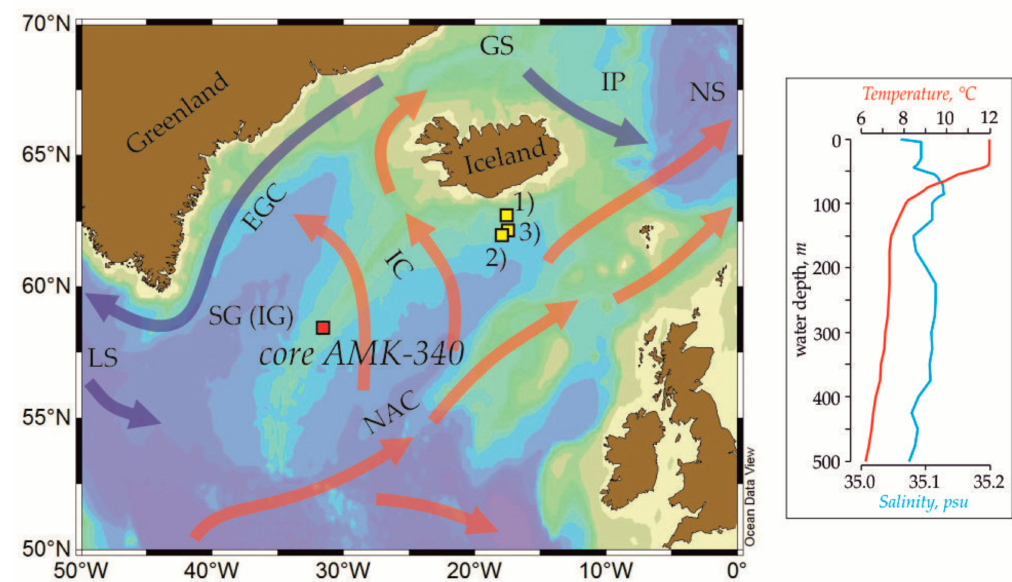
Figure 1. Core location (red square) and modern regional oceanography. Sediment cores (yellow squares) were mentioned in the paleoceanographic interpretations: (1) RAPiD-10-1P, (2) RAPiD-12-1K, (3) RAPiD-15-4P [13,14]. Vertical summer salinity and temperature profiles are from the World Ocean Atlas 2013 [11,15]. Red and blue arrows schematically show flows of the warm and cold waters, respectively. GS is Greenland Sea, IP is Iceland Plateau, NS is Norwegian Sea, EGC is East Greenland Current, IC is Irminger Current, SG (IG) is Subpolar (Irminger) Gyre, LS is Labrador Sea, NAC is North Atlantic Current.